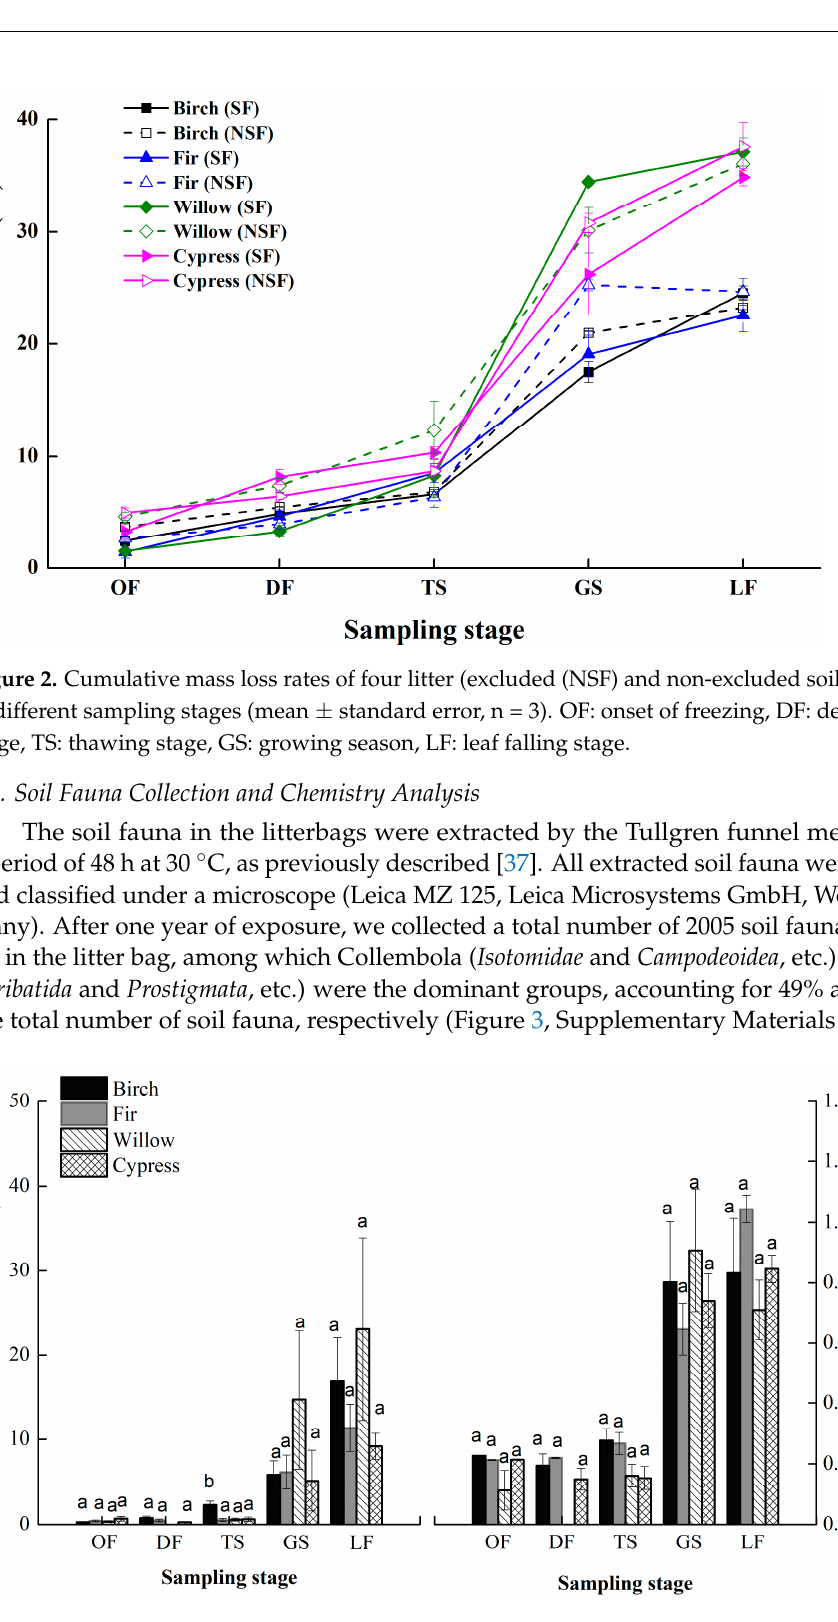
Figure 3. Individual and group density of soil fauna in different sampling stage (mean ± standard error, n = 3). OF: onset of freezing, DF: deep freezing stage, TS: thawing stage, GS: growing season, LF: leaf falling stage. The letters a and b mean in the sampling stage with different letters differ significantly, P < 0.05.